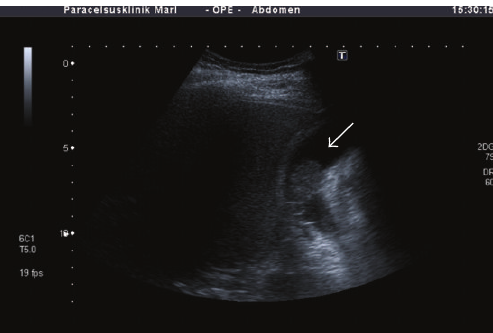
Figure 1: B-mode sonography showing a 25mm polypoid lesion within the gallbladder (arrow). The tumor appears to have broad contact to the gallbladder wall at two locations.